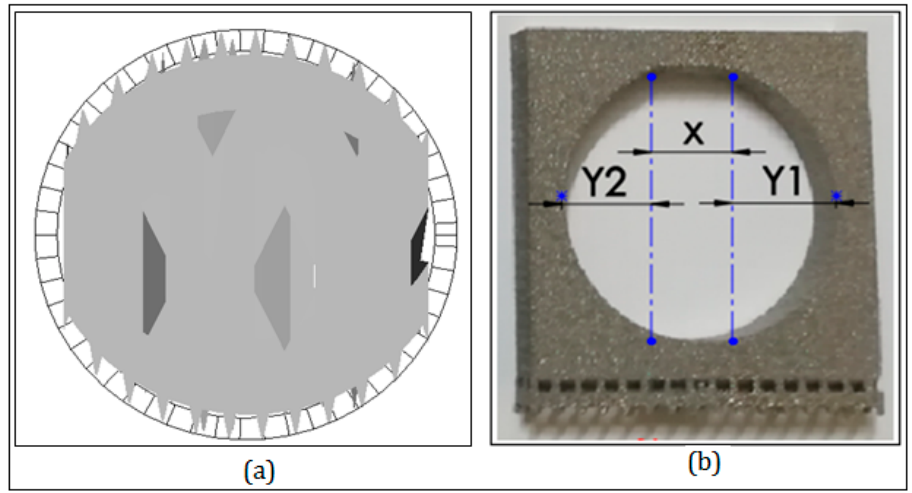
Figure 10. ( a ) Default support structures of round holes; ( b ) Critical and non-critical overhang regions.